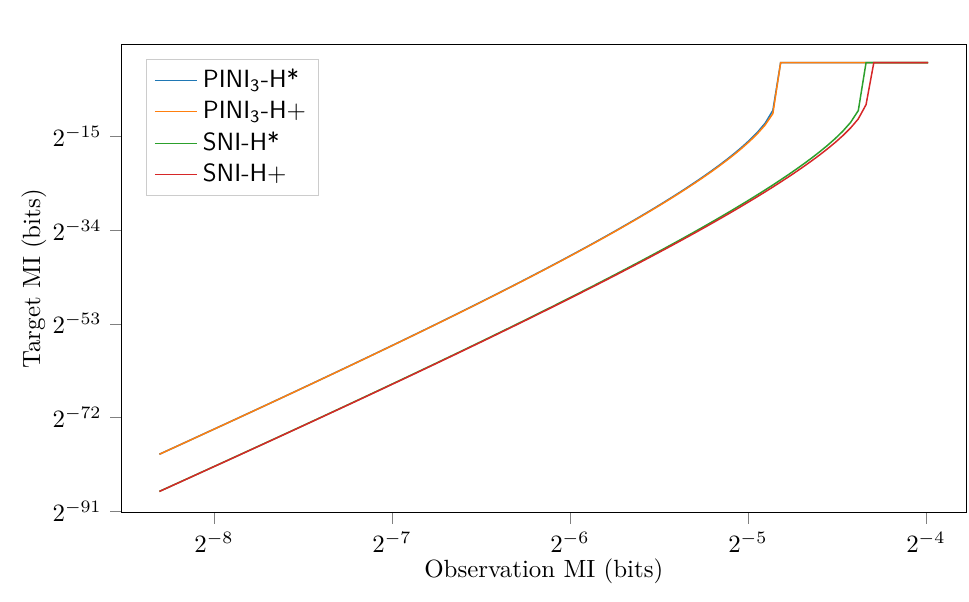
Figure 9: Target MI as a function of observation MI, for the SNI-H+ , SNI-H* , PINI 3 -H+ and PINI 3 -H* multiplication gadgets at order t =